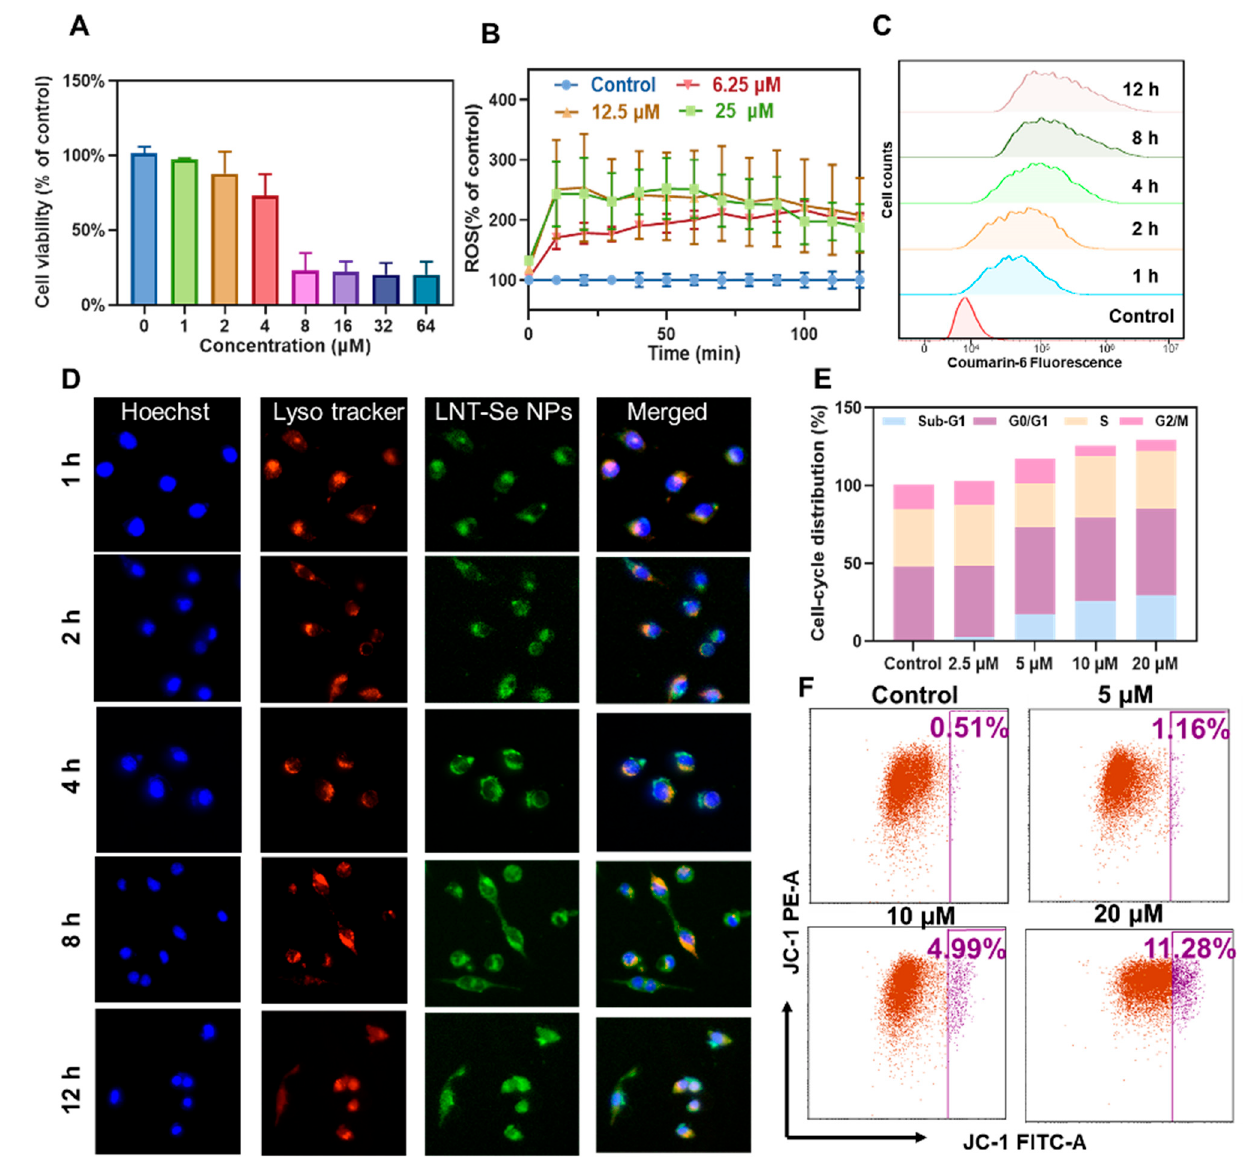
Figure 3. In vitro anticancer effect of LNT-SeNPs. ( A ) Viability of CT26 cells after the incubation of LNT-SeNPs at different concentrations for 72 h, where cells cultured under the same condition but without treatment were used as control. ( B ) Extracellular ROS levels after the incubation of LNT-SeNPs at different concentrations measured by the DCFH-DA assay. ( C ) Flow cytometric assay of CT26 cells after the incubation of LNT-SeNPs after different incubation times. ( D ) Intracellular trafficking of LNT-SeNPs in CT26 cells between 1 to 12 h. ( E ) Cell-cycle distribution of CT26 cells treated with LNT-SeNPs for 72 h. ( F ) Mitochondrial membrane potentials of LNT-SeNPs treated-CT26 cells using the JC-1 flow cytometric assay.